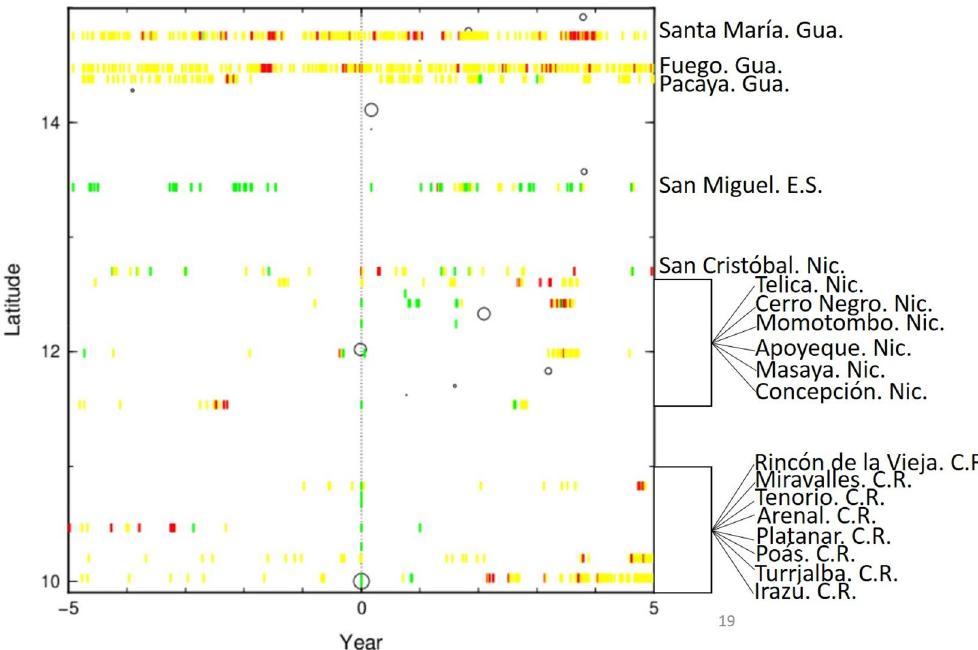
Figure 4. Volcanic unrest and earthquakes from 2007 (− 5) to 2017 (5). Dotted line (0) corresponds to the Costa Rica earthquake on September 5, 2012. Green represents the increase in seismicity in the volcanic system. Yellow indicates an increase in the temperature, deformation, degassing or, phreatic activity, or a number of small explosions. Red is related to the occurrence of large eruptions with considerable ashfall, explosions with ballistics and paroxysmal events. Blank space indicates that no information is available or that the volcanoes were in a state of